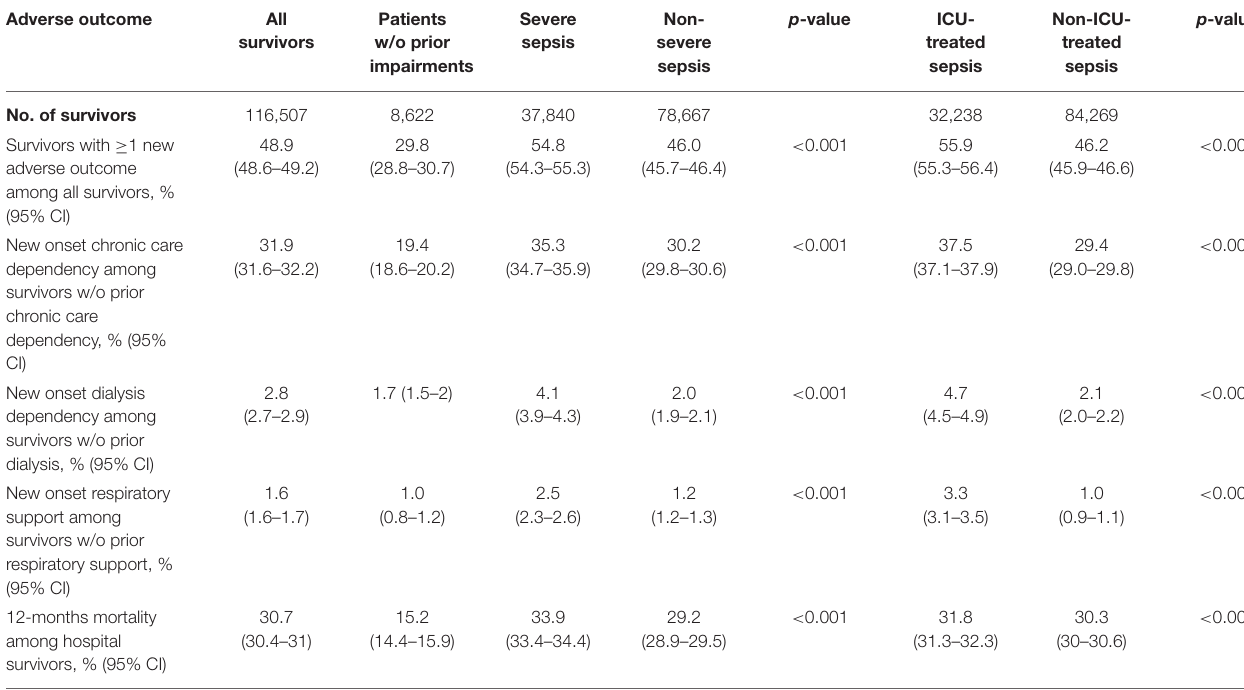
TABLE 1 | Occurrence of adverse outcomes 0–12 months after